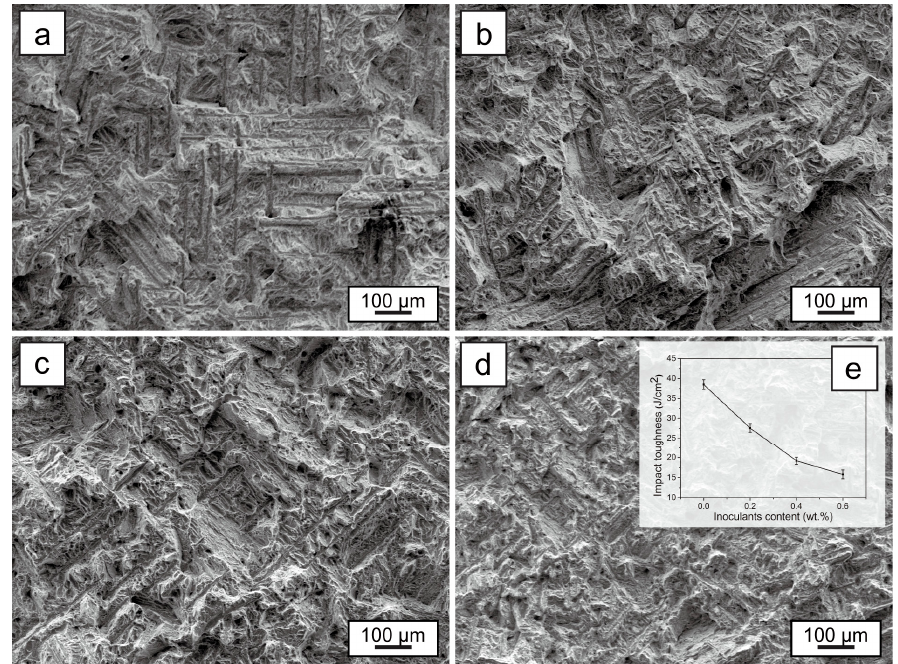
Figure 14. The impact test result of the TMCs: ( a ) the SEM image of the impact fracture of the TMCs unrefined; ( b ) the SEM image of the impact fracture of the TMCs refined by 0.2 wt % inoculants; ( c ) the SEM image of the impact fracture of the TMCs refined by 0.4 wt % inoculants; ( d ) the SEM image of the impact fracture of the TMCs refined by 0.6 wt % inoculants; ( e ) the impact toughness curve of the TMCs modified by inoculants with different weight fraction.